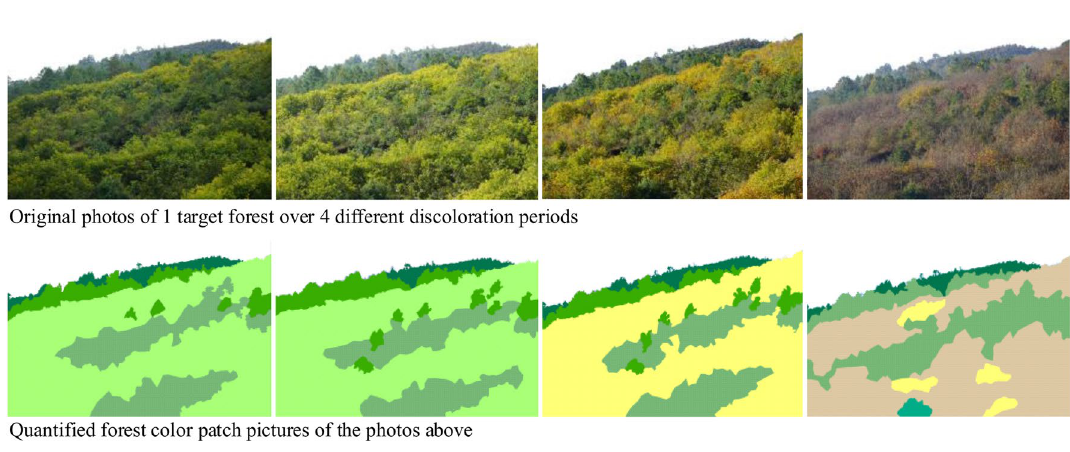
Figure 4. Color patch